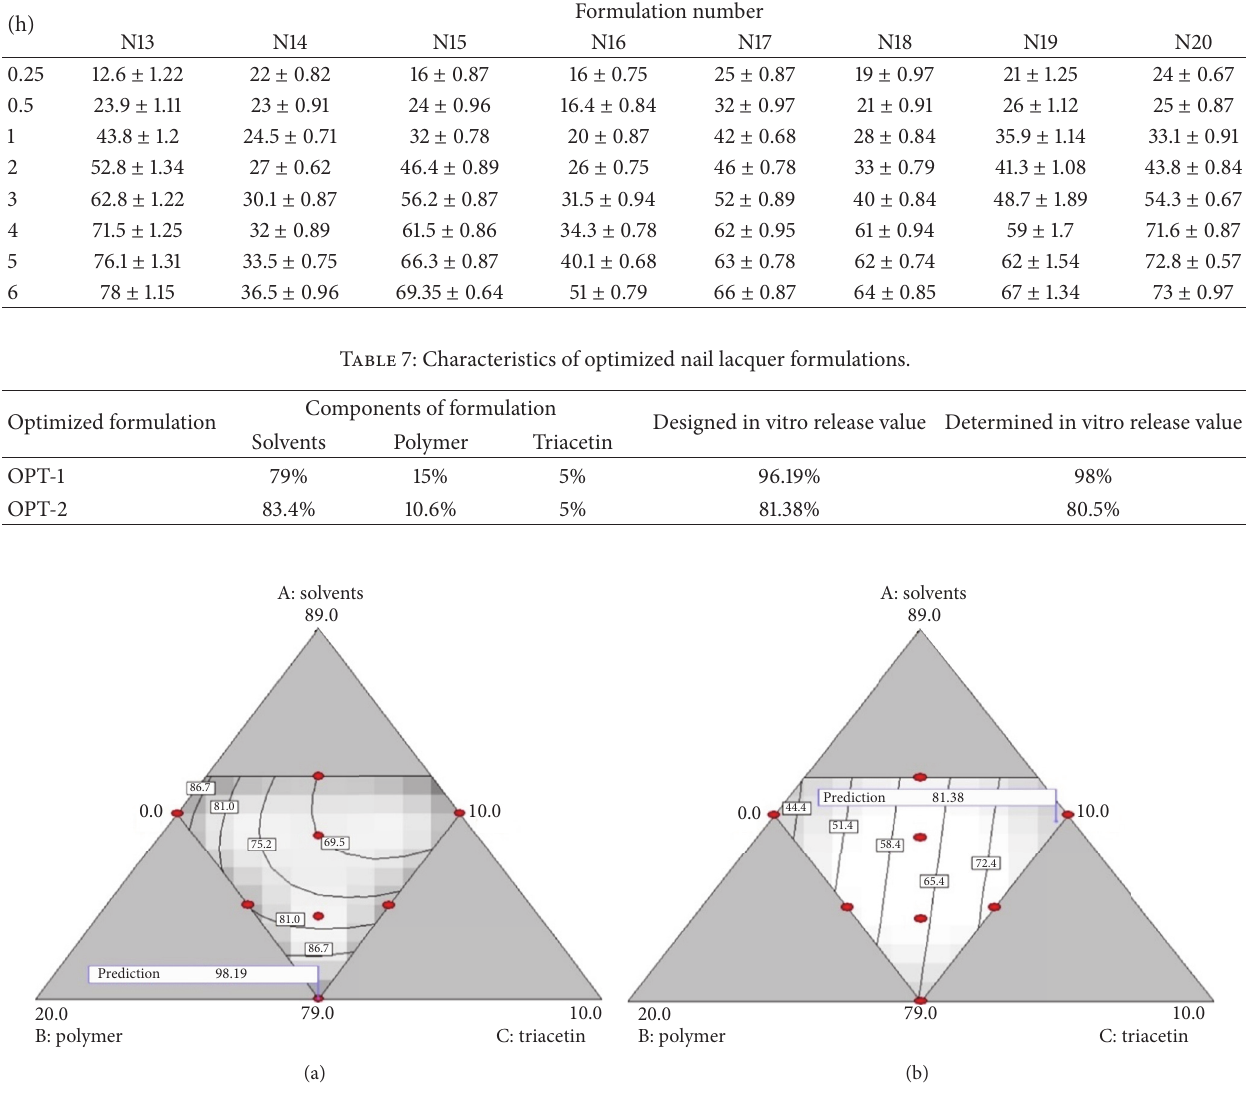
Figure 2: Areas of optimal composition of nail lacquers with highest desirability parameter: (a) OPT-1 formulation, Eudragit RL100 polymer; (b) OPT-2 formulation, Eudragit RS100